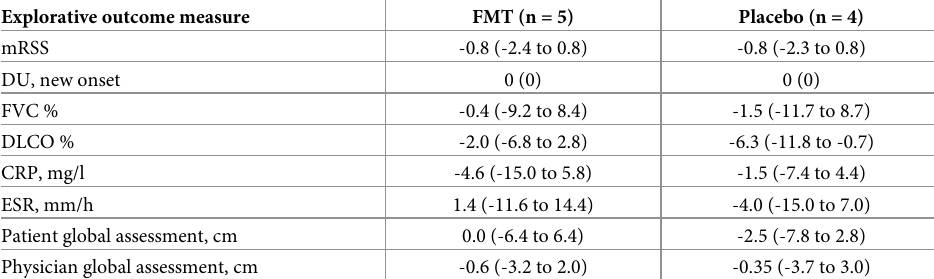
Table 3. Secondary clinical outcome measures in the ReSScue pilot study.